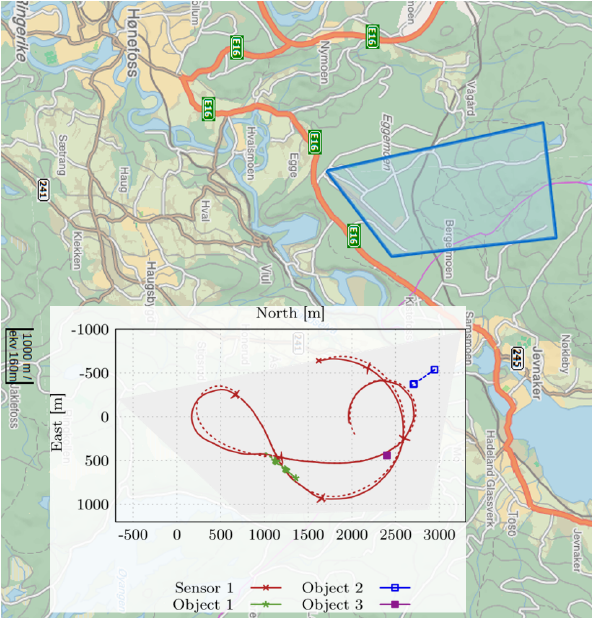
Figure 19: Map over experiment region, in an experi- ment with one mobile sensor and three ”ob- jects” to be monitored. Planned (dashed) and actual (solid) paths shown.